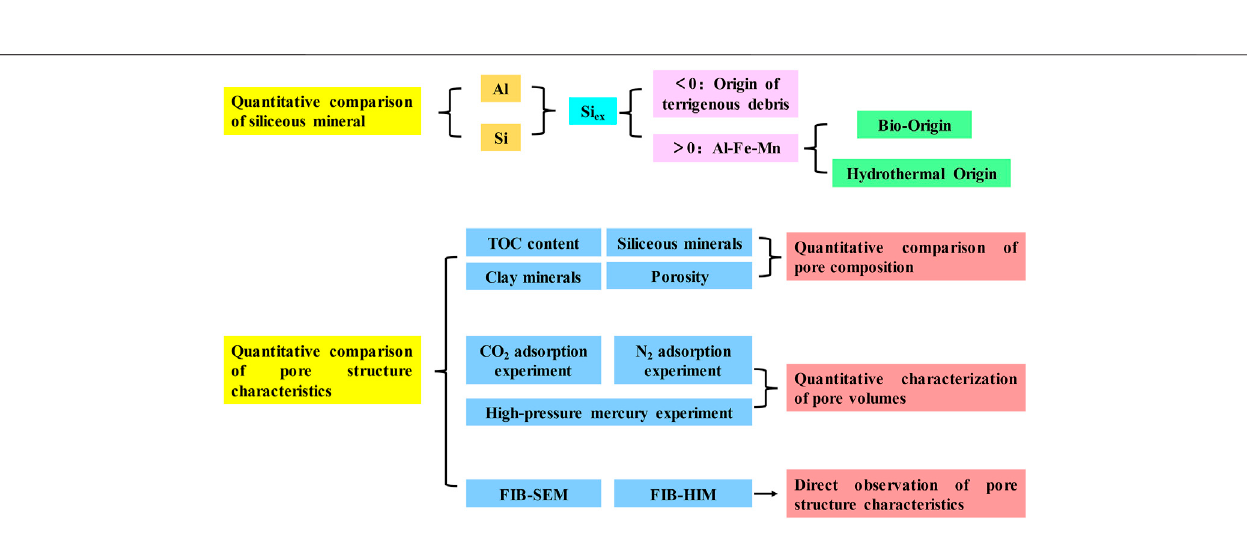
Frontiers in Earth Science |